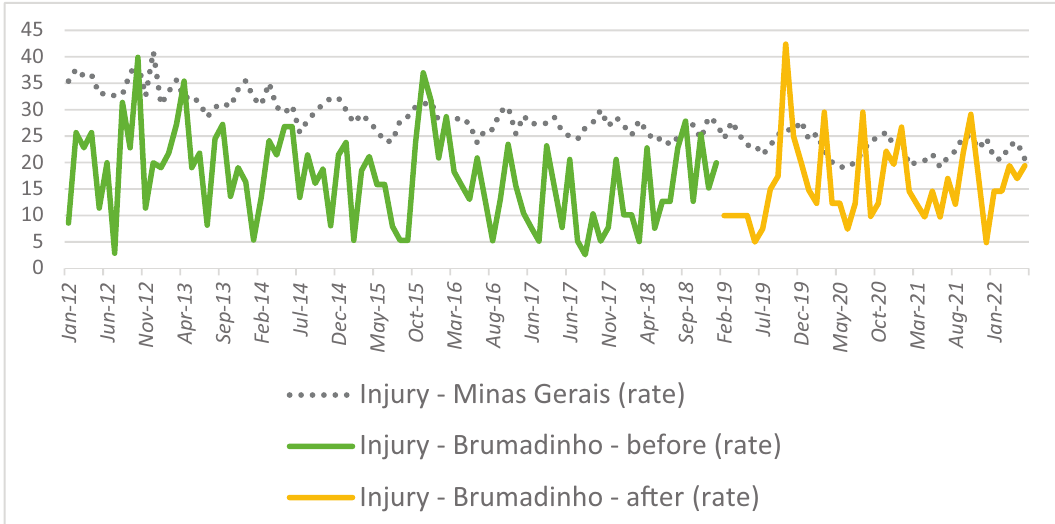
Injury - Minas Gerais (rate) Injury - Brumadinho - before (rate) Injury - Brumadinho - a(cid:31)er (rate) Figure 14. Rate of injuries per month, for Minas Gerais and Brumadinho – 2012- 2022